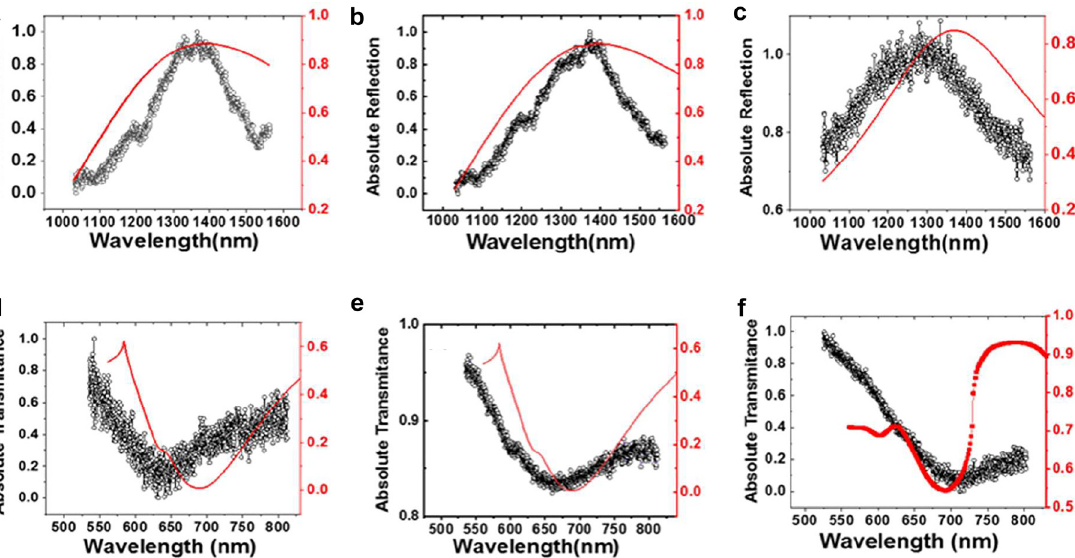
Figure4: Comparisonbetweensimulatedandmeasuredabsolutereflectionspectraof(a)SRRAu-DRM(b)heptagonalAu-DRM(c)SRRAu-DRM for y -polarization in the fundamental wavelength region. Comparison between simulated and measured absolute transmission spectra of